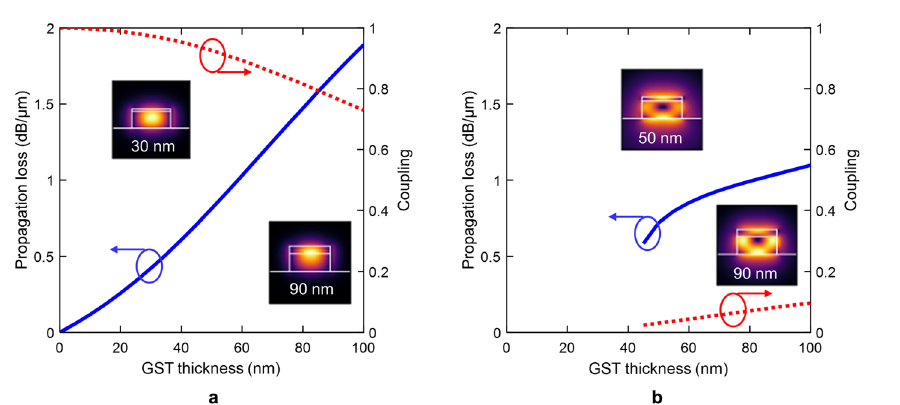
Figure 2. ( a ) Illustration of the power transfer between a silicon and GST/Si waveguide. Due to the optical mismatch between both waveguides, the incident power ( P in ) is radiated outside the waveguide ( P rad ), reflected ( P r ), and transmitted ( P t ). ( b ) Illustration of the technique used to obtain the coupling efficiency between the optical modes of the GST/Si waveguide and the fundamental TE mode of the silicon waveguide by exploiting the reciprocity property of the coupling process.